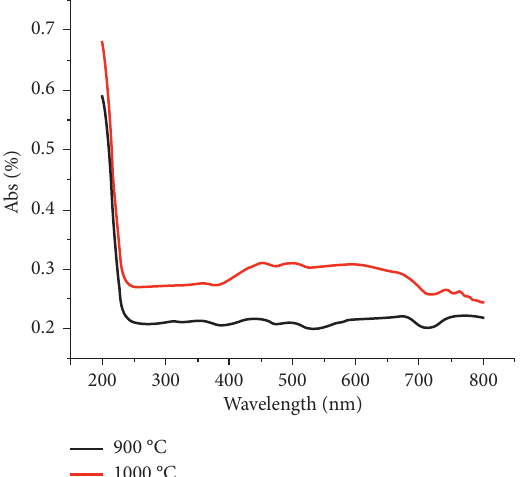
Figure 8: UV-vis absorbance spectra of CaTiO